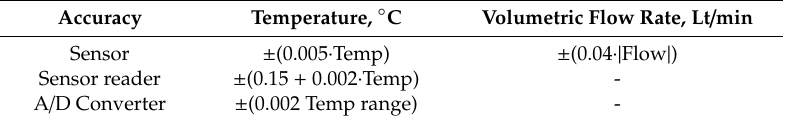
Table 2. Accuracy of the temperature and flow rate sensors and A/D converter.